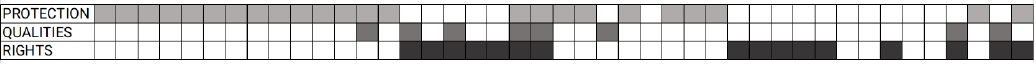
Figure 7. Dominant semantic domains (each box representing the sub-corpus of a president’s